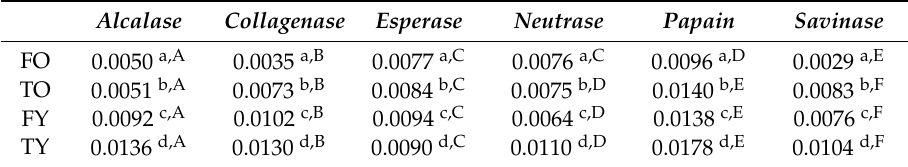
For each enzyme, significant differences among bones ( p < 0.05) are indicated by different superscript lowercase letters; for each bone, differences among enzymes ( p < 0.05) are indicated by different superscript capital letters.